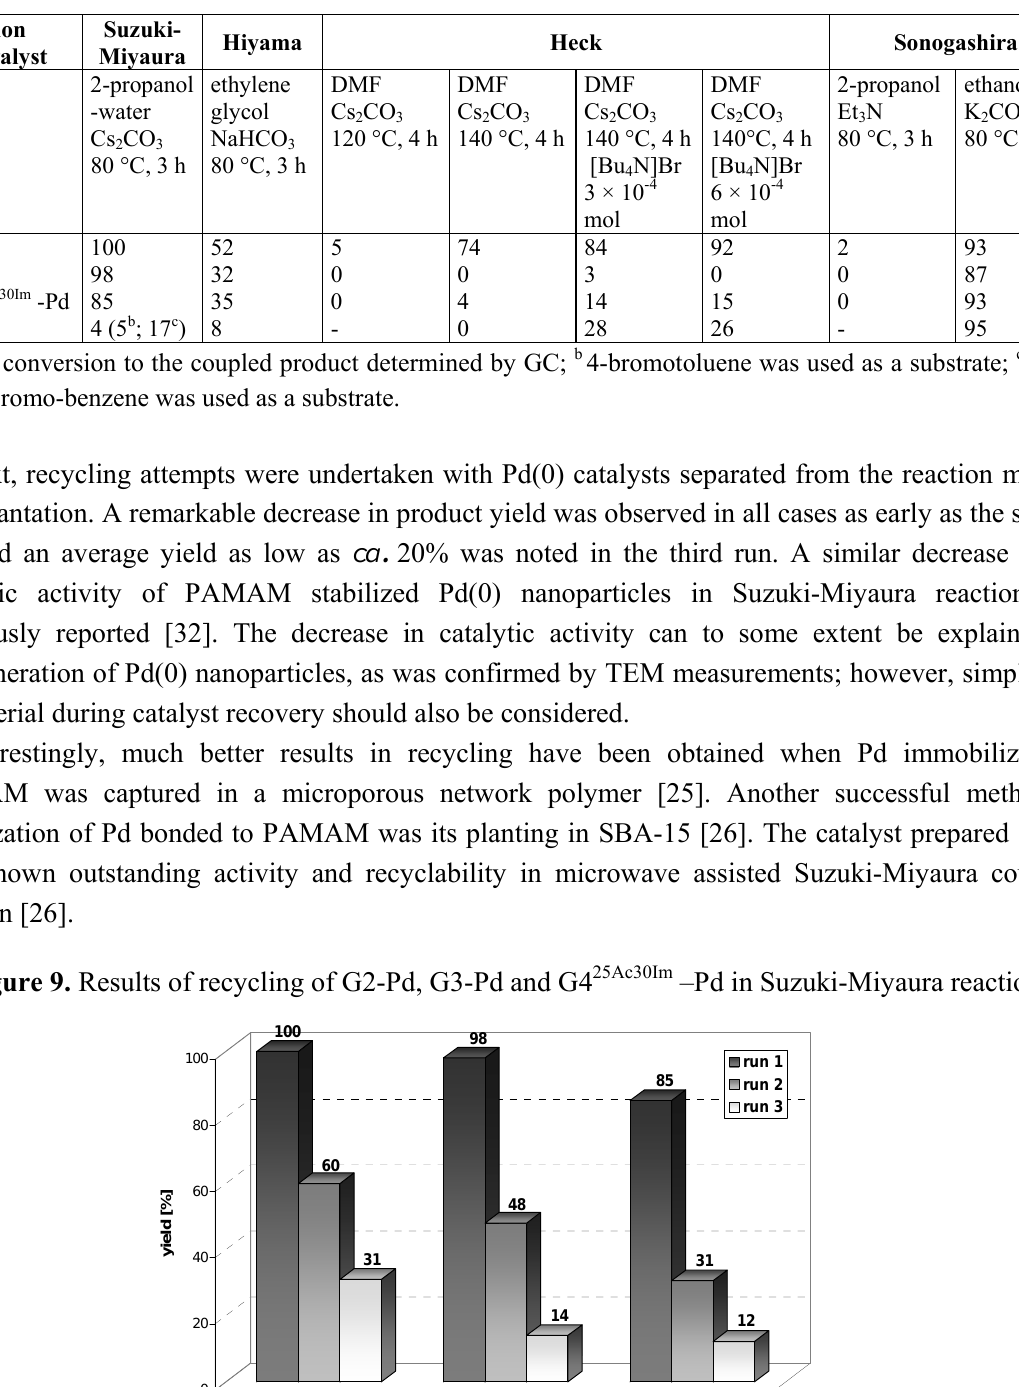
Table 2. The yield a of products obtained in C-C cross-coupling reactions catalyzed by G2- Pd, G3-Pd, G4 25Ac30Im –Pd and 4 -Pd.